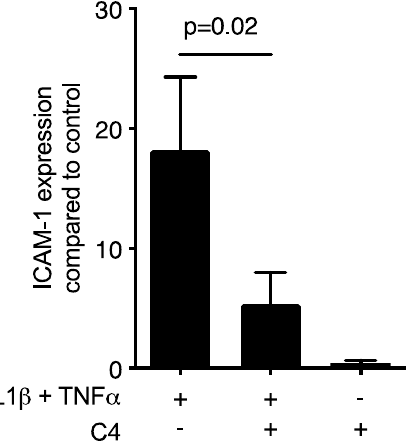
Figure 2. Butyrate suppresses the cytokine-induced increase of ICAM-1 in primary epithelial cells. Cells were exposed to 10 mM butyrate (C4) in the presence of 10 ng / mL IL1 β and TNF α . ( + ), indicates presence; ( − ), indicates absence. Data represent the mean change of ICAM-1 expression ± standard deviation. n = 3. Statistical analysis was based on t -test and p -values are indicated.